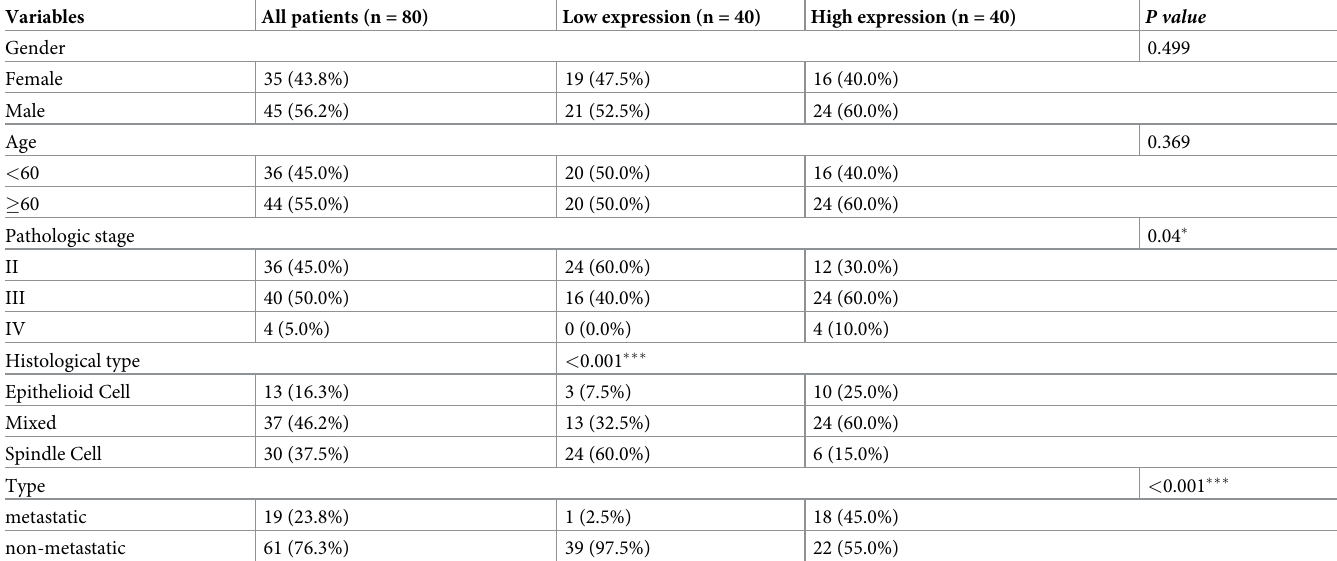
Table 1. Characteristics and clinical data of uveal melanoma patients from